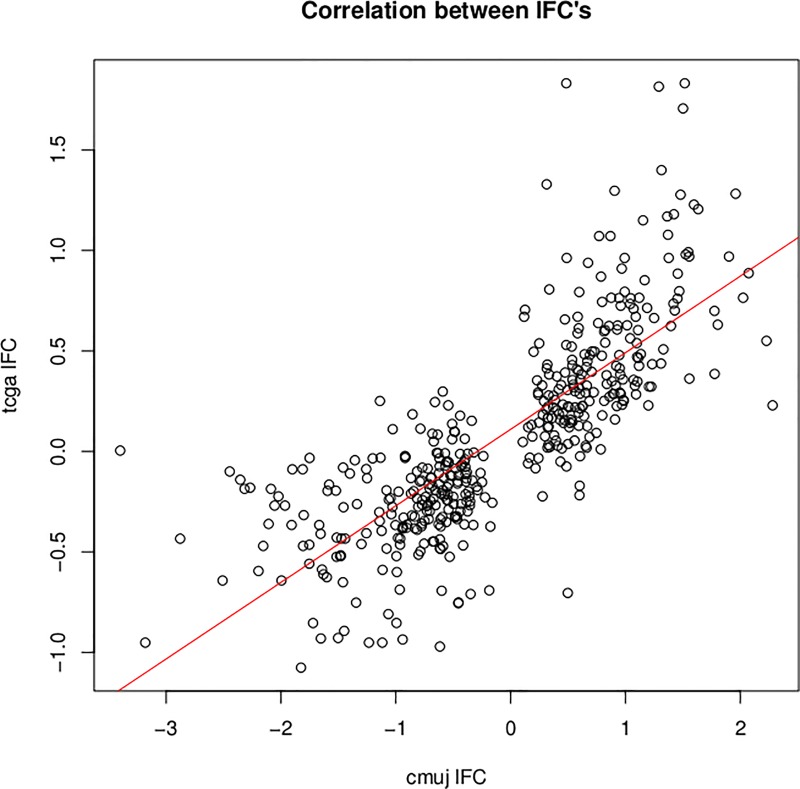
Correlation coefficient plot for the logFoldChanges between the two cohorts–UJ CM and TCGA.